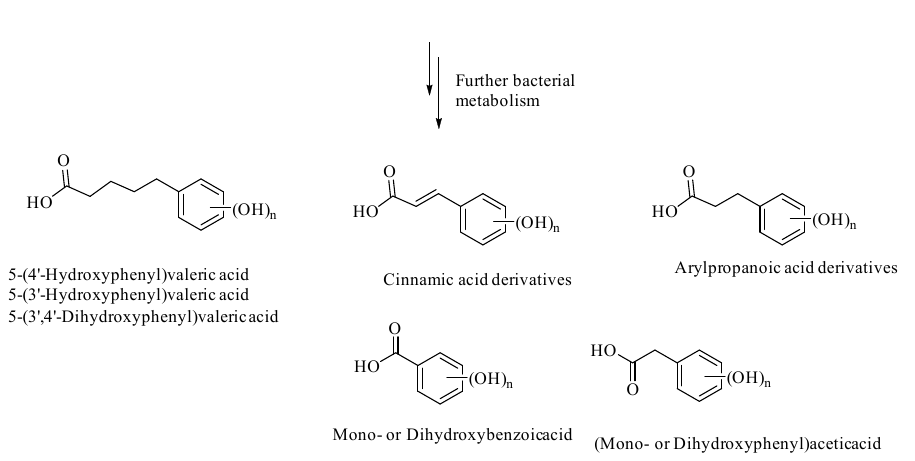
Figure 3. Gut bacterial metabolites of epicatechin and procyanidin B2.